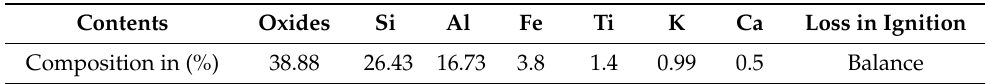
Table 2. Chemical composition of fly